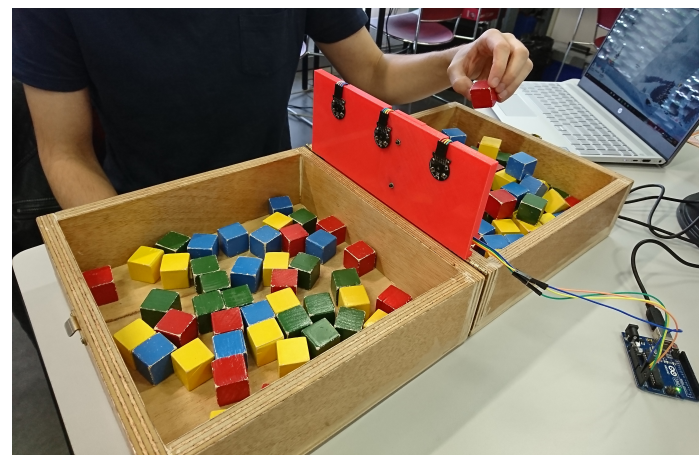
Figure 9. Prototype of the sensorized barrier.